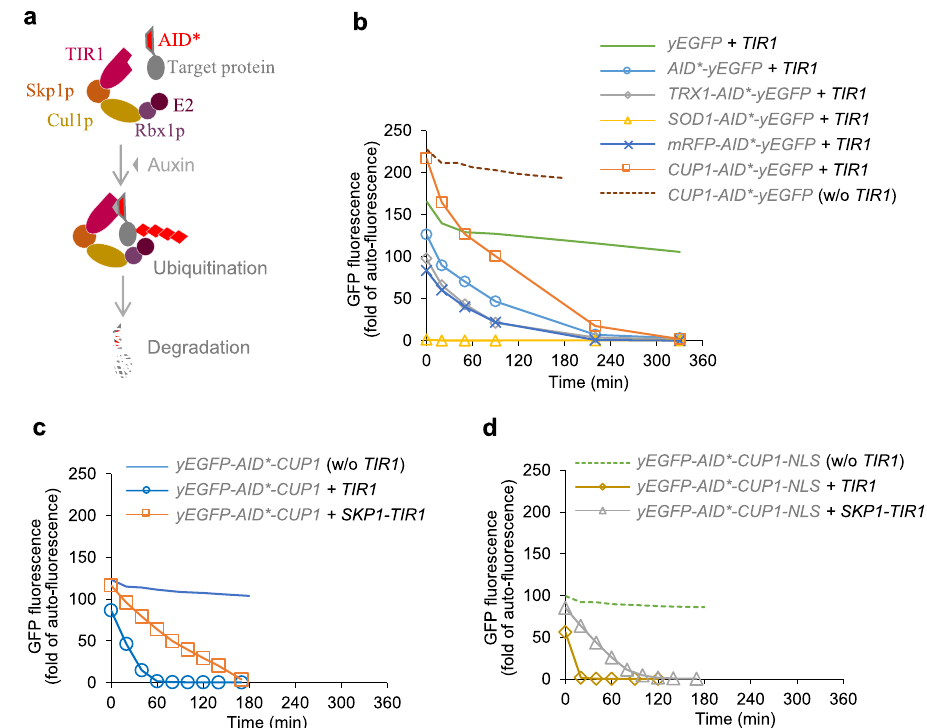
Fig. 1 Characterising and optimising the auxin-inducible protein degradation system in yeast. a Schematic of auxin-inducible protein degradation. b – d Depletion of cytosolic or nucleus-localising green fl uorescent protein (GFP) with/without auxin-inducible degron tags fused in strains with/without TIR1 or SKP1-TIR1 expressed. N-terminal fusions ( b ), C-terminal fusions of AID* and Cup1 ( c ), and C-terminal fusions of AID*, Cup1 and the nuclear localization signal NLS ( d ). Engineered yeast strains are listed in Supplementary Table 1. The yeast cells were grown in 2-(N-morpholino)ethanesulfonic acid (MES)-buffered synthetic mineral salt medium (prepared from yeast nitrogen base, YNB) with 20 g L − 1 glucose as the carbon source to early exponential phase. GFP fl uorescence was measured at t = 0, and synthetic auxin 1-Naphthaleneacetic acid (NAA) was immediately added to a fi nal concentration of 1 mM to start the assay. GFP fl uorescence is expressed as fold-change of exponential-phase auto- fl uorescence of the reference strain. Mean values are shown ( N = 2 or 3 independent biological replicates). Source data in b – d are provided as a Source Data fi